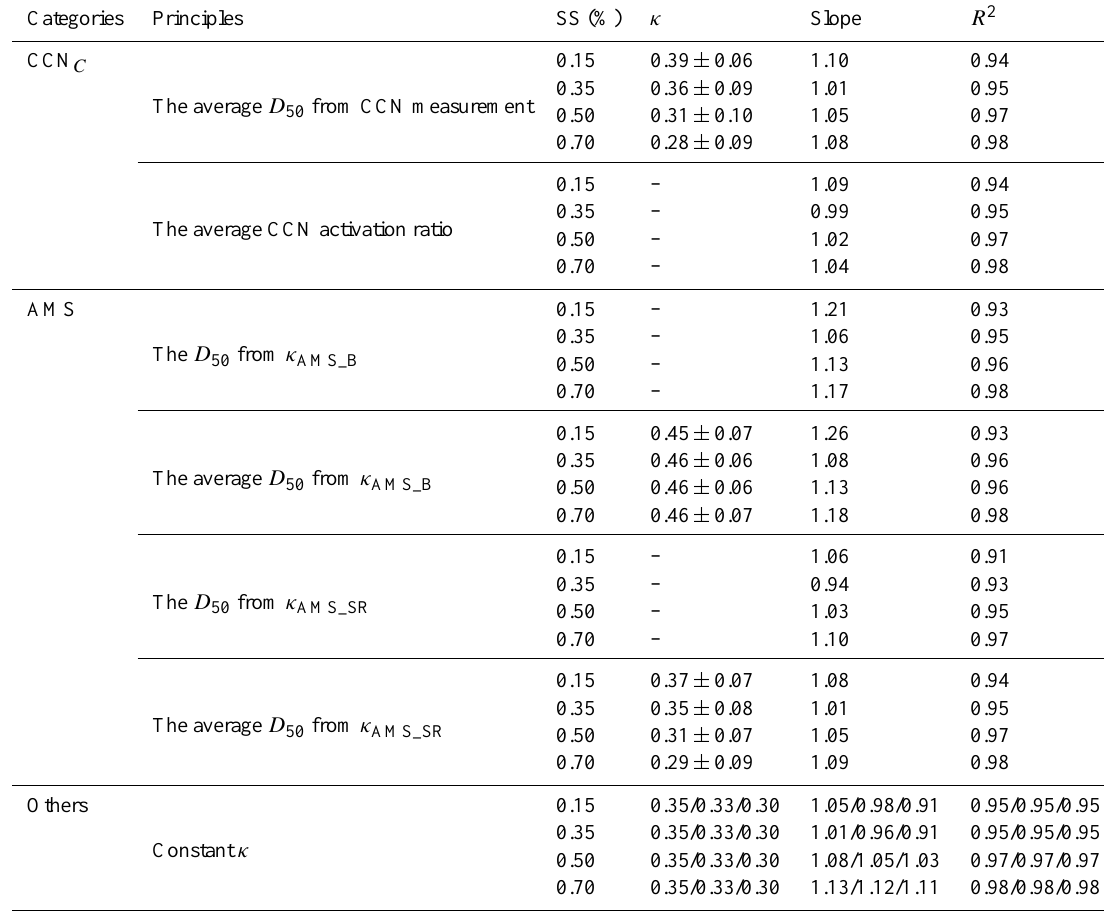
Table 4. Overview of N CCN predictions, κ from D 50 based on CCN measurement and derived from equation 3 based on AMS measurement are shown as mean ± standard deviation, slope and R 2 are from the least square fit between the calculated N CCN and measured